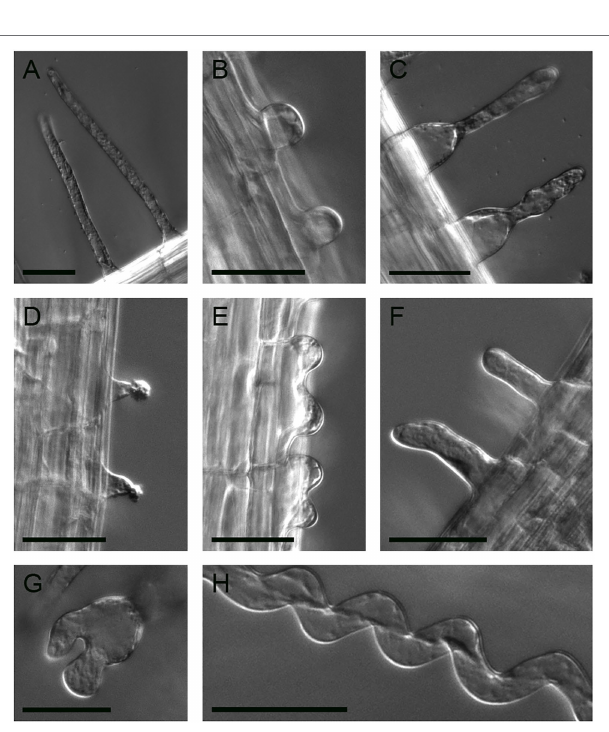
FIGURE 3 | Root hair morphogenesis phenotypes. (A) Wild-type root hair. (B) Root hair growth stops after bulge formation (line 366). (C) Root hairs are swollen at the base (line 1,221). (D) Bursting root hairs (line 1,185). (E) Multiple outgrowths from each epidermal cell (line 1,384). (F) Short root hairs (line 1,091). (G) Branched root hairs (line 216). (H) Wavy root hairs (line 216). Scale bar: 50 μ